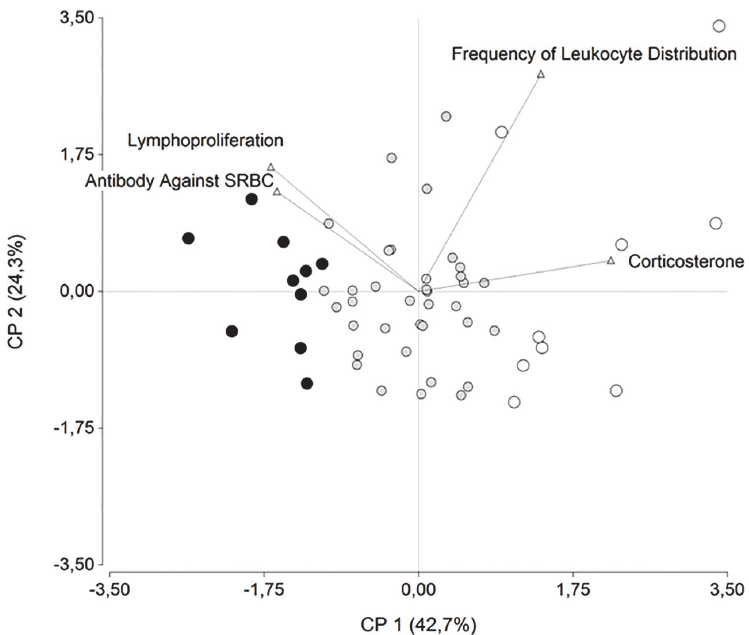
Fig 1. Exploration of data variability. Principal Component Analysis Bi-plot graph. Each dot represents an animal in the study and triangles represent the explanatory variables used in the analysis. Full white dots ( (cid:1) ) and full black dots ( ● ) represent extreme low and high CORT birds respectively. The eigenvalues of each PC are shown in brackets next to each component.